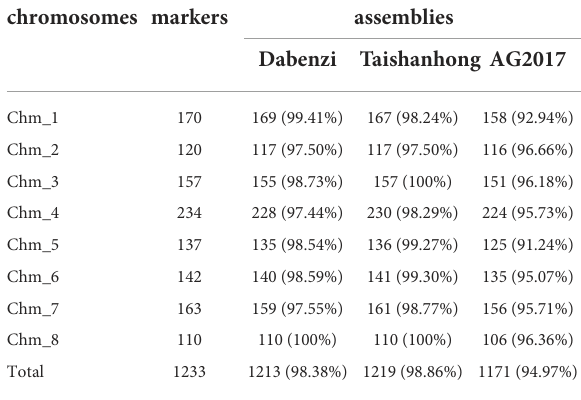
TABLE 4 A summary of 1233 PIP marker-based comparative mapping of Tunisia chromosomes with Dabenzi, Taishanhong, and AG 2017 assemblies, revealing syntenic